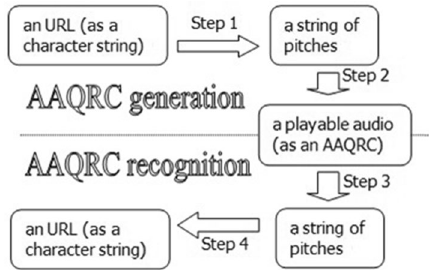
Figure 1. AAQRC generation and its